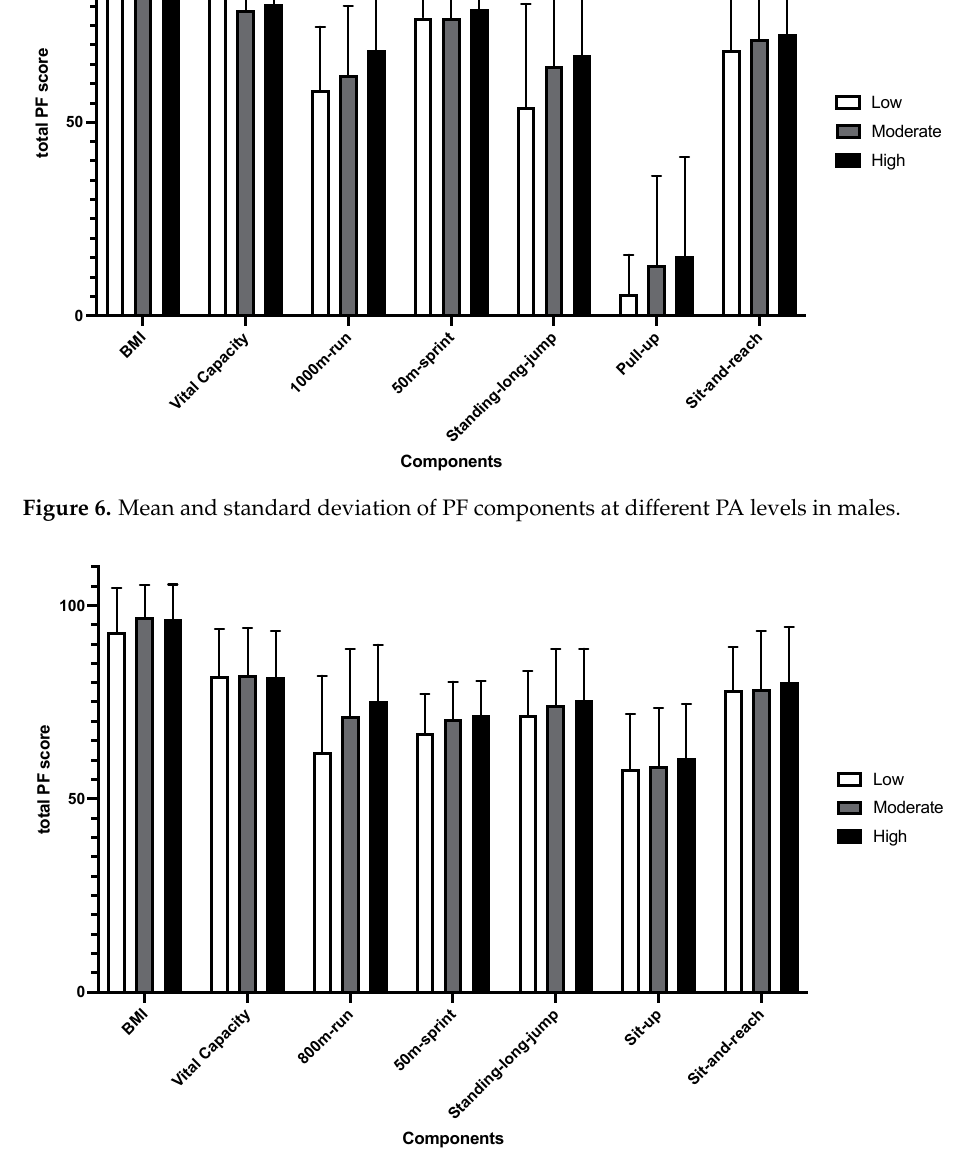
Figure 7. Mean and standard deviation of PF components at different PA levels in females.